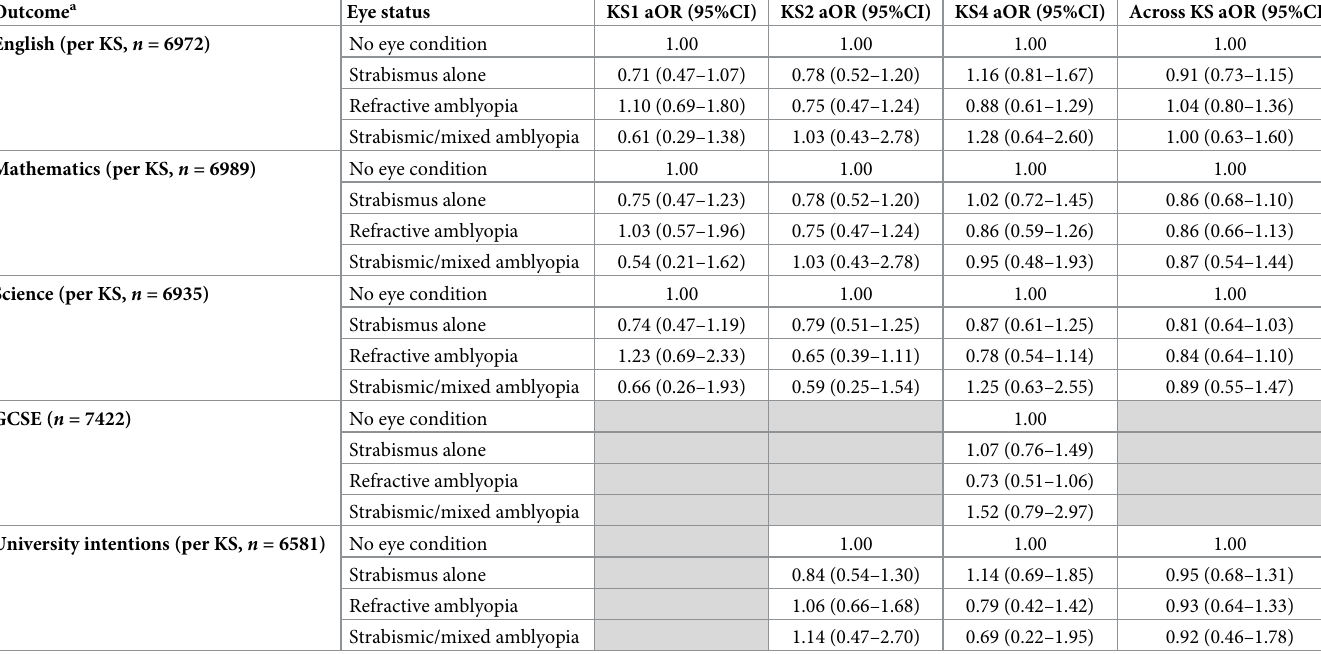
Table 3. Adjusted odds ratios of subject-specific Key Stage (KS) attainment levels and age-related trajectories, GCSE attainment, and university intentions. Outcome